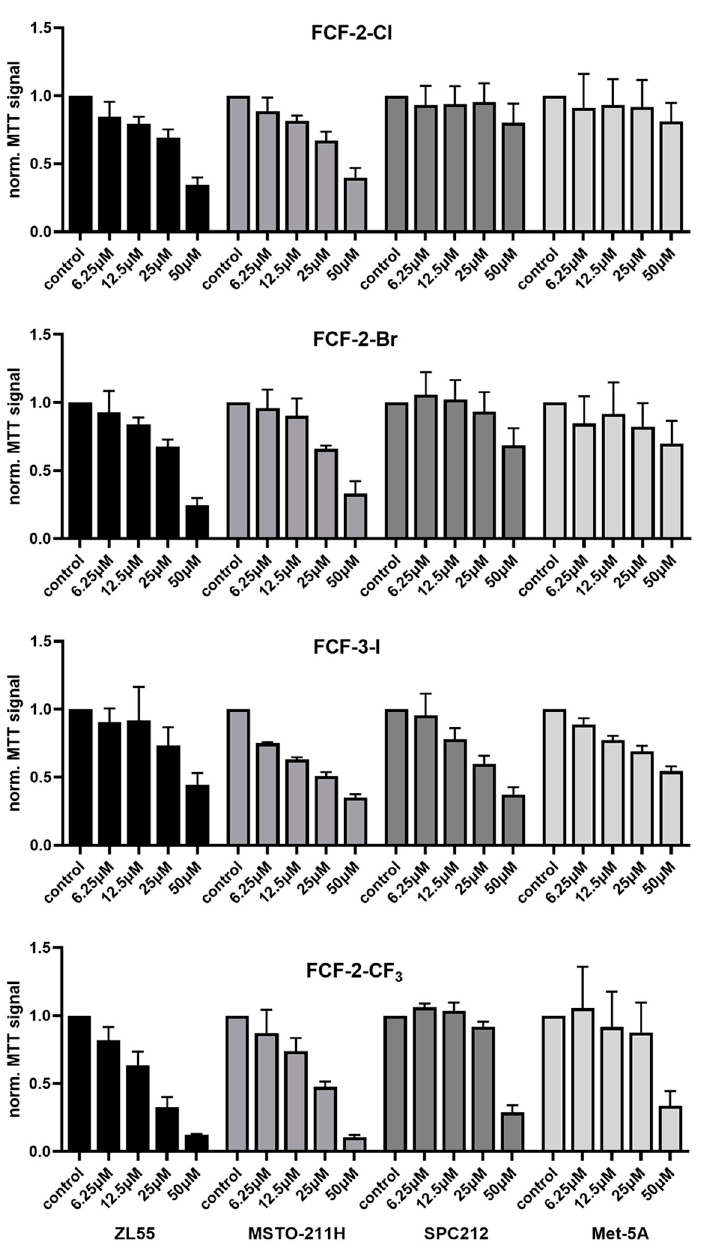
Figure 2. Dose–response curves obtained with (from left to right) ZL55, MSTO-211H, SPC212 and Met-5A cells treated with FCF-2-Cl (parental FCF), FCF-2-Br, FCF-3-I and FCF-2-CF 3 for 96 h. MTT signals (normalized to non-treated cells from the control) of cells exposed to 6.25, 12.5, 25 and 50 µM FCF (and three FCF analogs). The results are the average of 3–4 independent experiments (mean ± SD); each condition was tested in three wells in each experiment. The results from the more sensitive ZL55 and MSTO-211H cells were further used to estimate the IC 50 values (Supplementary Figures S1 and S2).